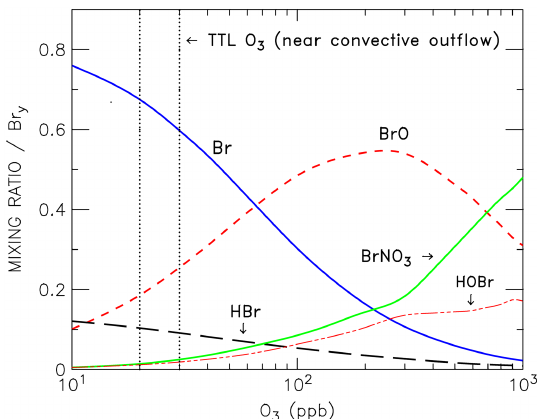
Figure 8. Box-model partitioning of Br y species as a function of ozone mixing ratio. The abundances (normalized to total Br y ) are from diurnal photochemical steady state conditions at local noon. Inputs for aerosol surface area, inorganic chlorine, and γ HOBr + HBr are for Run_1a